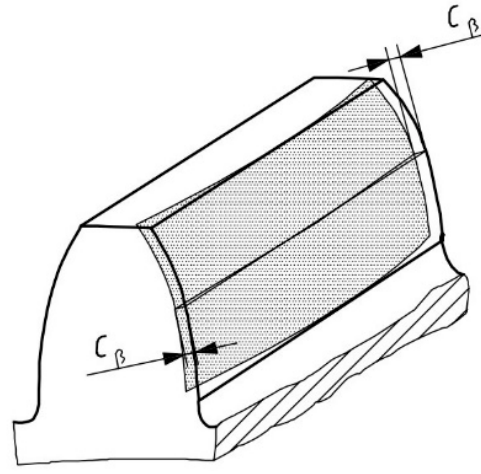
Figure 17. Gear crowning modification.